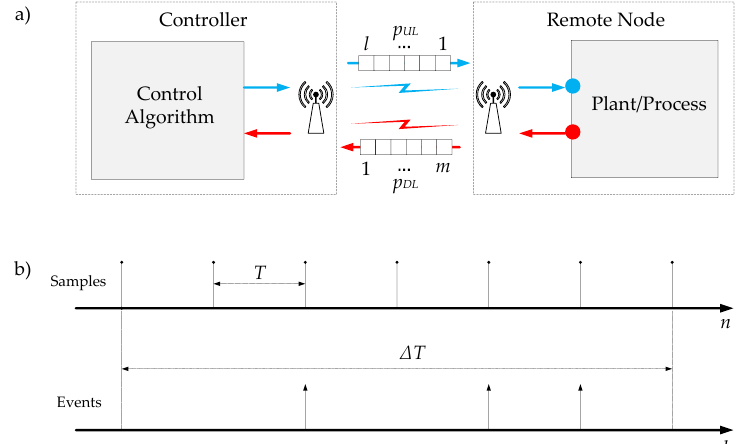
Figure 4. Bandwidth utilization model: ( a ) control architecture; and ( b ) time diagrams for discrete-time and event-based